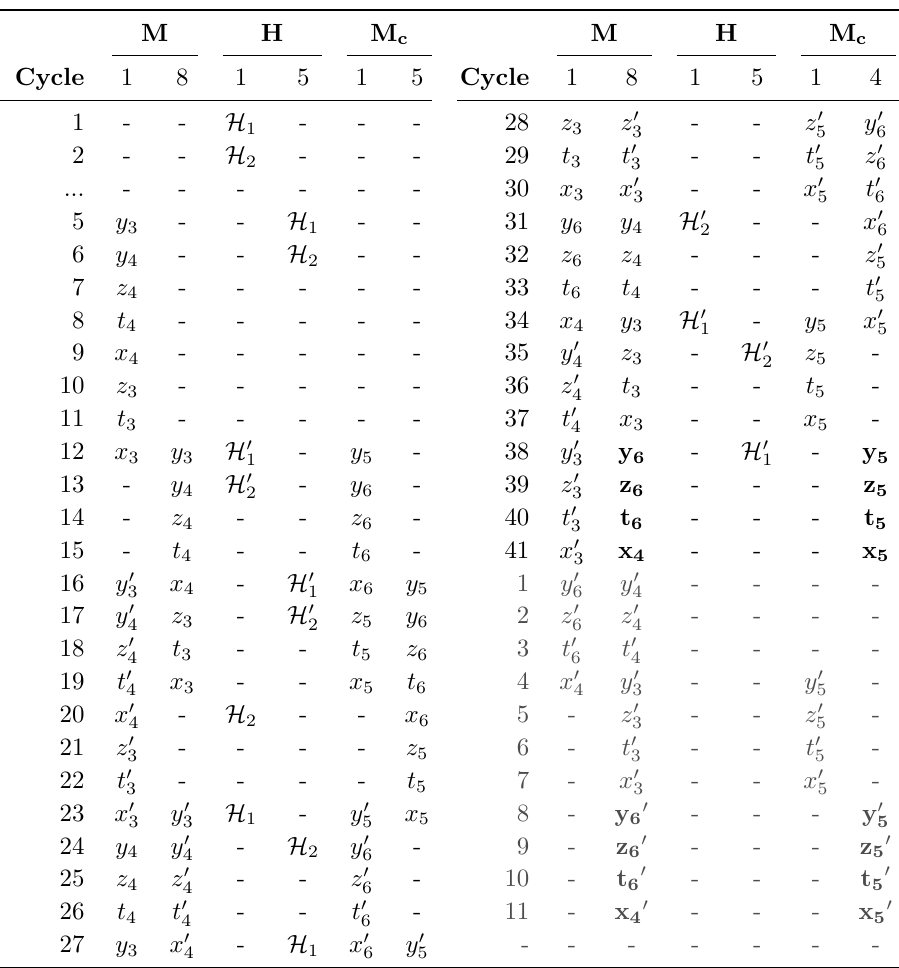
Table 5: Instruction scheduling for single ladder step as described in Algorithm 4 ( mont _ ladder ) for the modular multiplier ( M ), the constant modular multiplier ( M c ), and the Hadamard transform module ( H